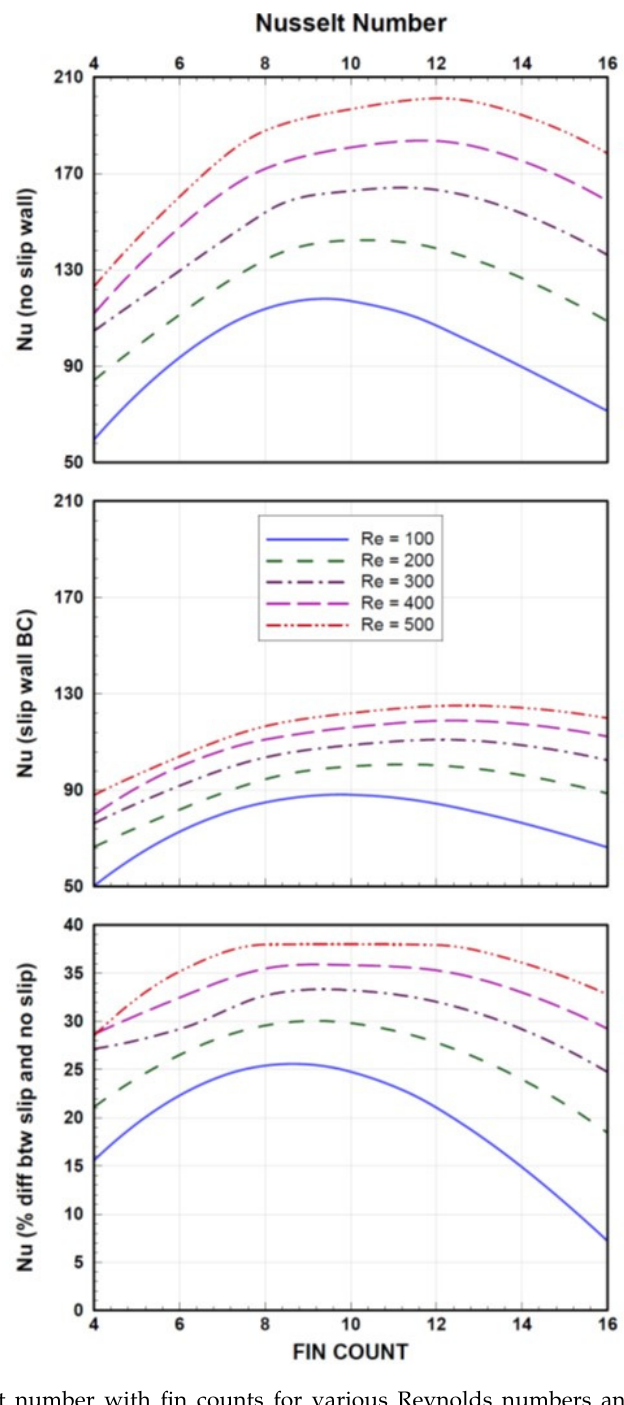
Figure 9. Nusselt number with fin counts for various Reynolds numbers and hydrophilic and hydrophobic fin surfaces. % difference of temperature parameter is also given for comparison.